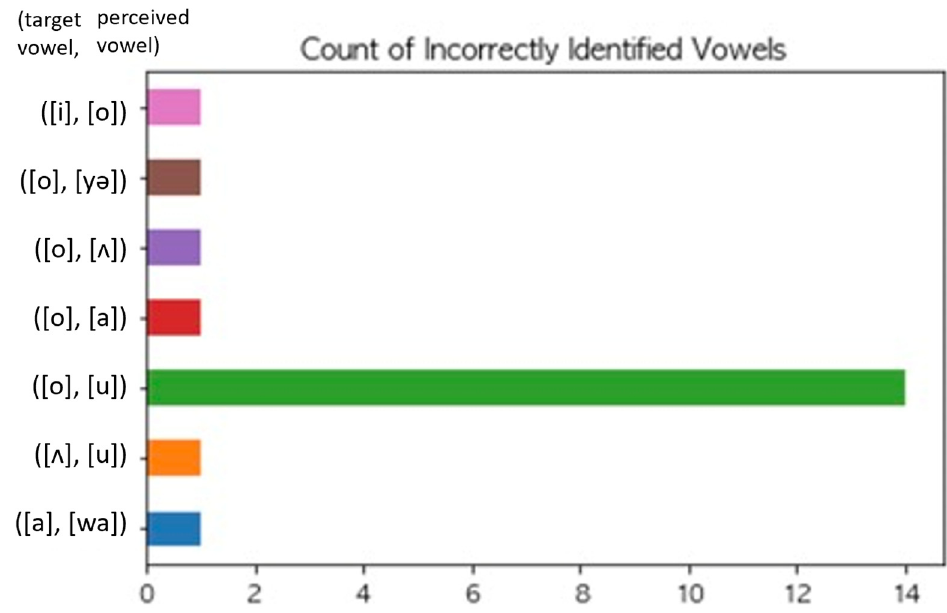
Figure 4. Count of incorrectly identified vowels.